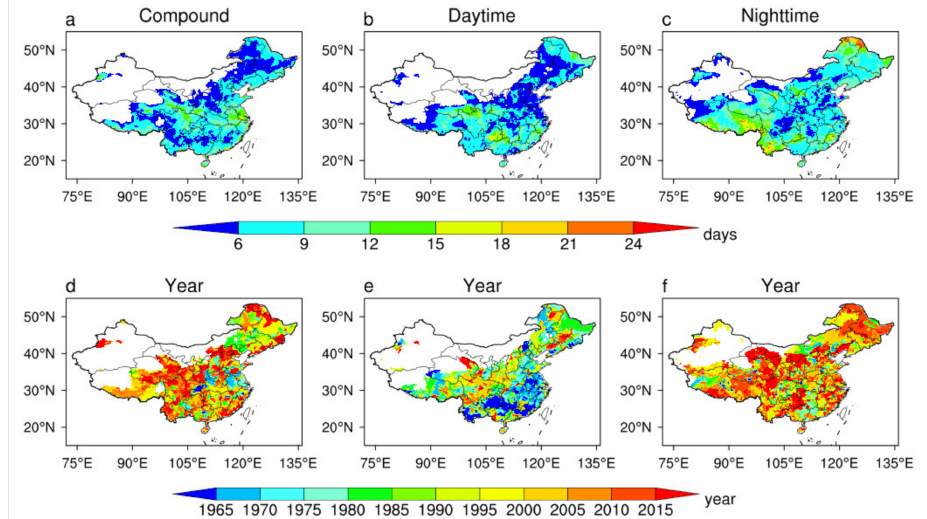
Figure 6. The longest duration of the wet ( a ) compound, ( b ) daytime and ( c ) nighttime HWs during 1961–2020, and ( d – f ) the year corresponding to the longest duration.